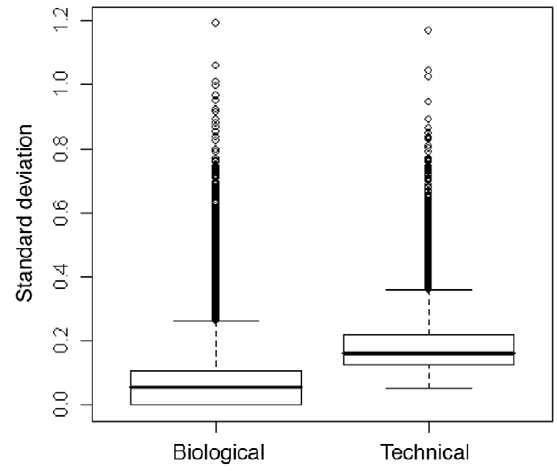
Figure 4. Standard deviation of all genes for biological and technical variance, showing median standard deviation, inter- quartile ranges and outliers.